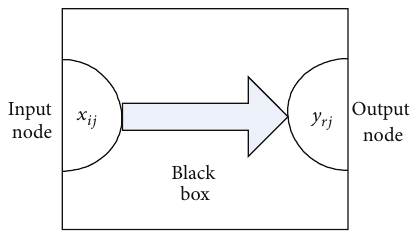
Figure 1: The structure of conventional DEA.